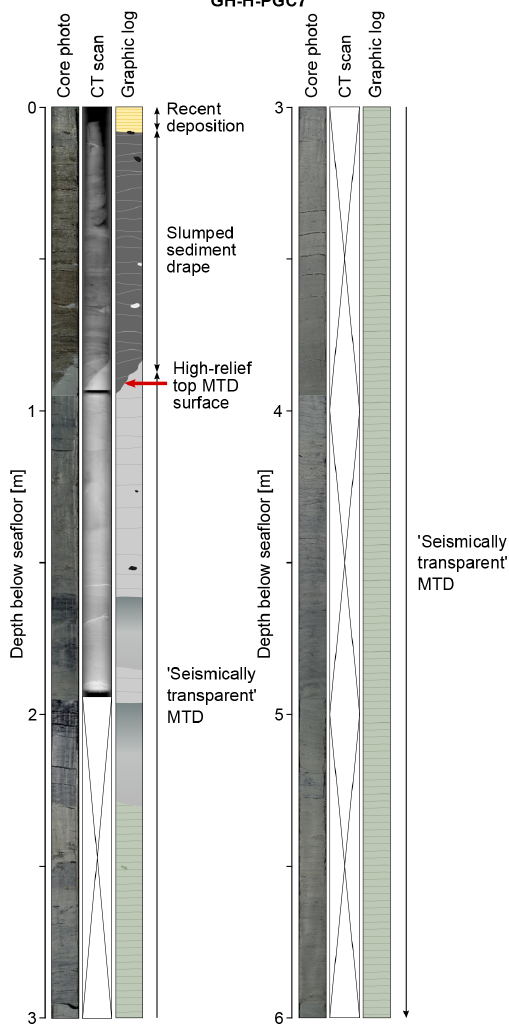
Figure 2. Piston gravity core GH-H-PGC7 (see Fig. 1 for location). Core photograph, X-ray-computed tomography image (note: only first 2m is scanned) and interpreted graphical log. The “seismi- cally transparent” MTD corresponds to the mass-transport deposit labelled in Fig. 1b.